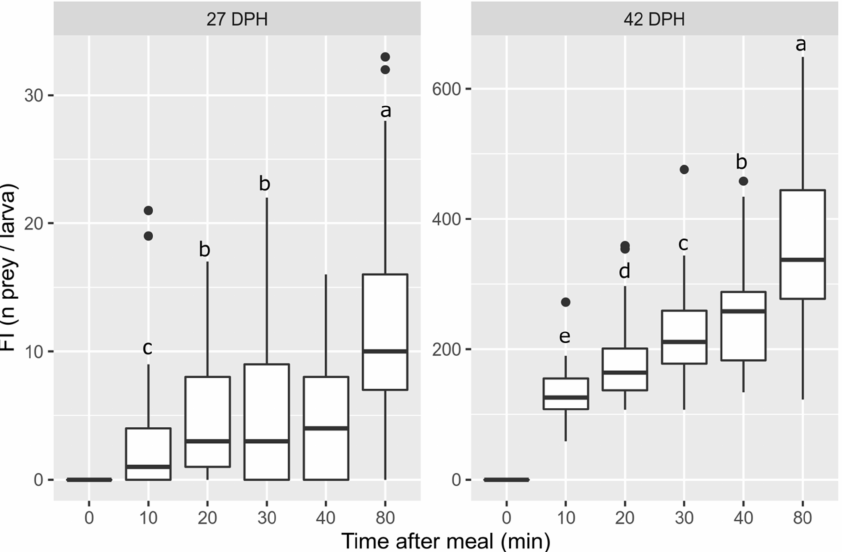
Figure 2. Feeding intensity of Sparus aurata larvae, fasted (t0) and after being fed (10 to 80 min) with live prey, at 27 and 42 days post-hatching (DPH). Different letters represent significant differ- ences among times after feeding (Kruskal–Wallis, p < 0.05, followed by paired comparisons using Mann–Whitney U test, p < 0.05), whereas the asterisk represents differences between 27 and 42 DPH larvae at each time after feeding (Mann–Whitney U, p < 0.05). Boxplot: black horizontal line repre- sents the median, white the interquartile range, delimited below and above by 1st and 3rd quartile, respectively, the extreme lines below and above (whiskers) represent minimum and maximum values (excluding outliers), respectively, and the black dots represent outliers.